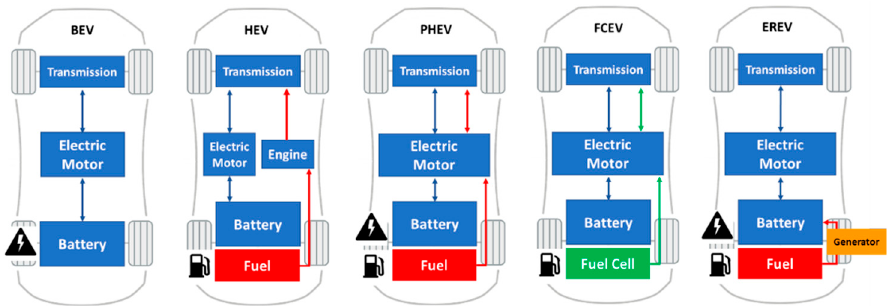
Figure 8. EV types and